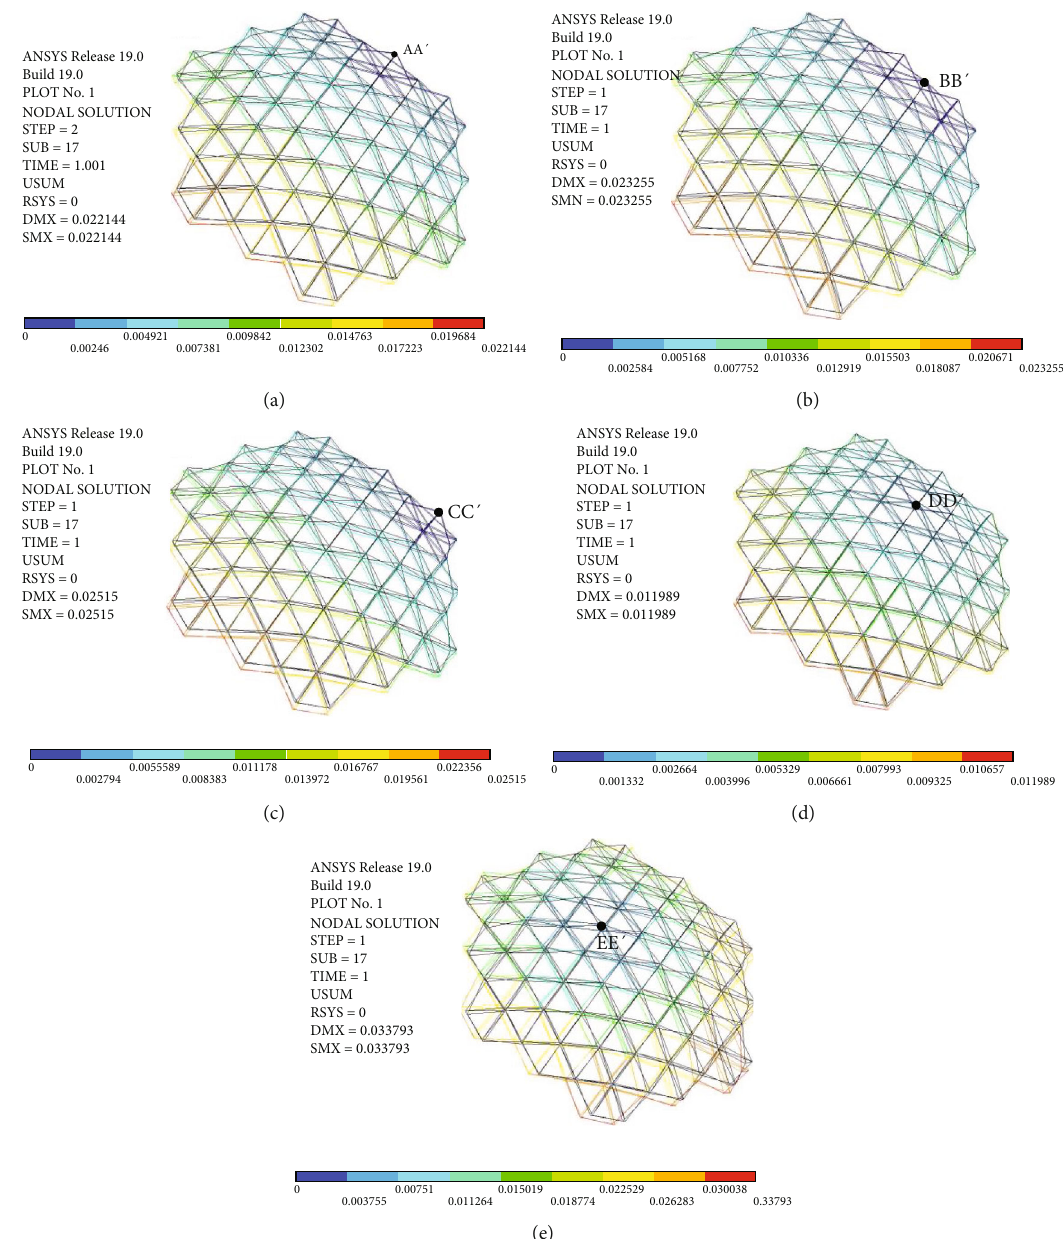
Figure 12: Overall deformation of structures with di ff erent constraints. (a) The constraint at AA ′ . (b) The constraint at BB ′ . (c) The constraint at CC ′ . (d) The constraint at DD ′ . (e) The constraint at EE ′